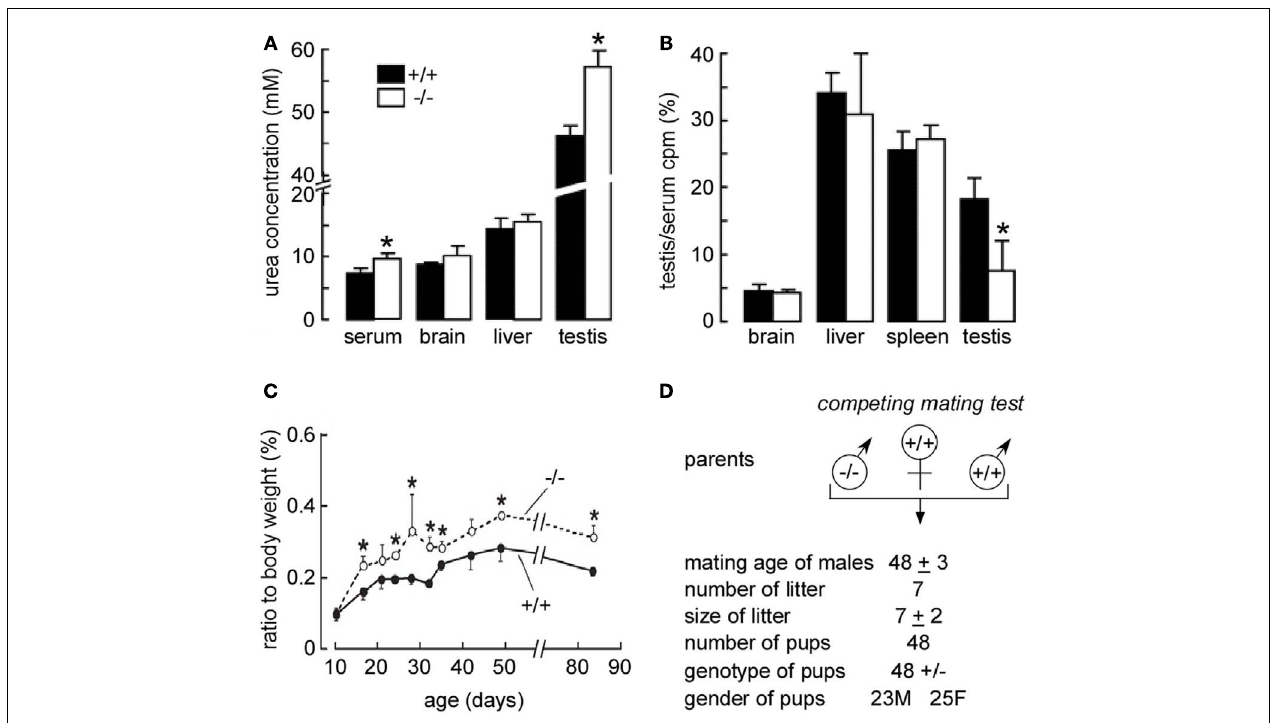
expressed as means ± SE ( n = 4 mice). * p < 0.01 vs.WT mice. (C) Age-related changes in testis weights.The left testis were isolated and weighed.The x -axis shows the age of the mice, and the y -axis shows the testis percentage of body weight ( n = 6, * p < 0.05). (D) Breeding performance of maturing male mice. Male (M) mice at 35days of age were housed with 10-week-oldWT female (F) mice. Data are shown as means ± SE for seven pairs of competing mates ( left ) and seven pairs ofWT controls ( right ). Reproduced from Guo et al.